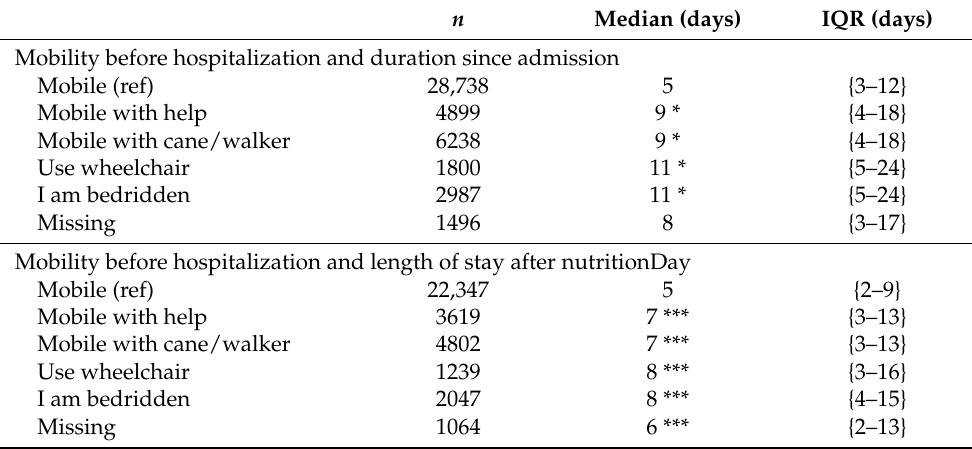
Table 5. Eating on nutritionDay and length of stay after nutritionDay. n Median (days) IQR